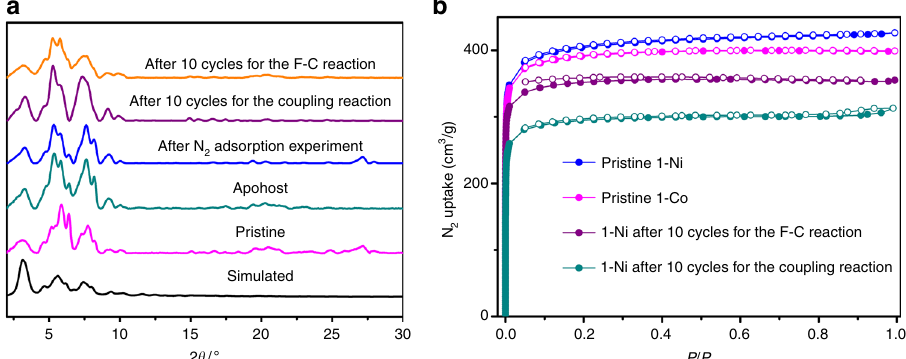
Fig. 3 PXRD and N 2 adsorption/desoption spectra. a PXRD patterns of 1 -Ni. b N 2 adsorption ( fi lled symbols) and desorption (open symbols) isotherms at 77 K